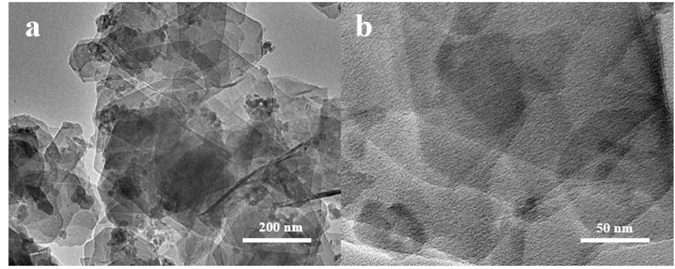
Figure 6. ( a , b ) TEM images of 6Mo(N)-HMCM-49 with different magnifications. Nanomaterials 2020 , 10 , x FOR PEER REVIEW